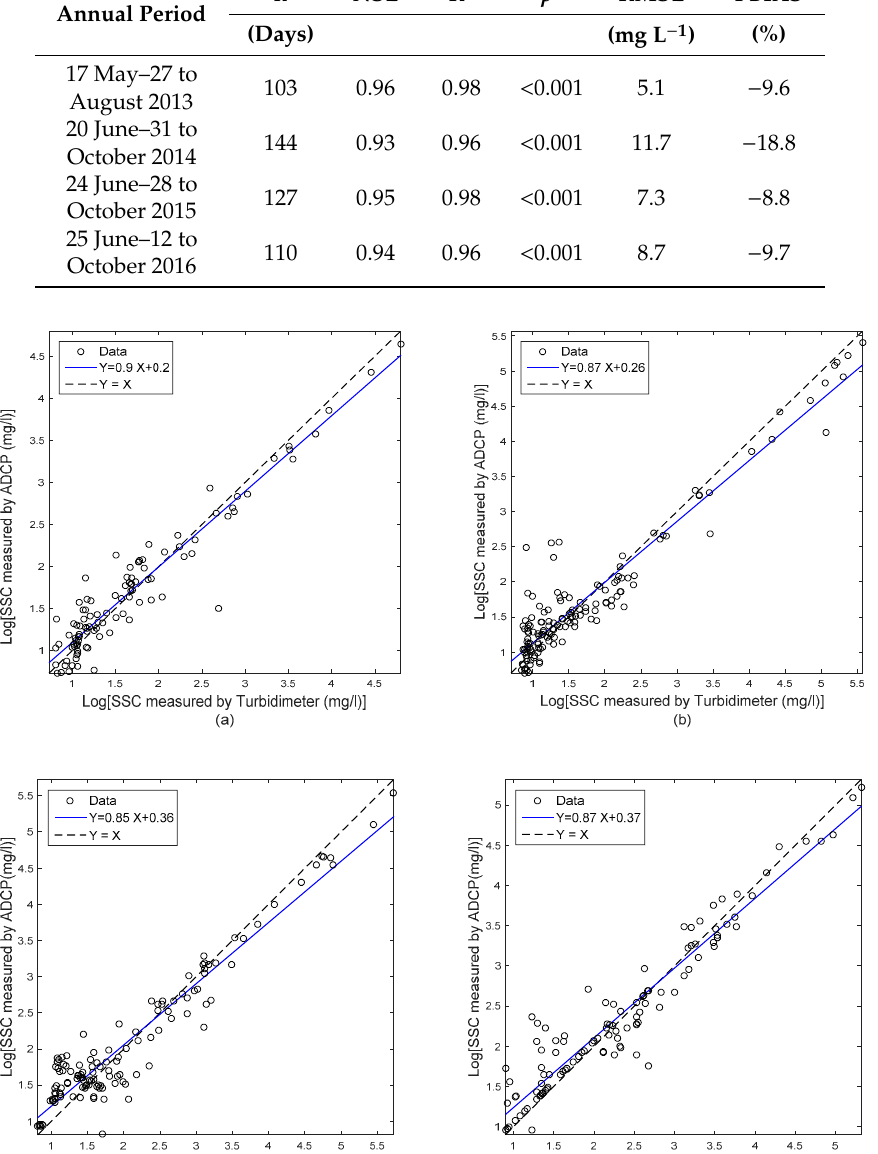
Table 1. Statistics for acoustic backscattered versus optical backscattered data.